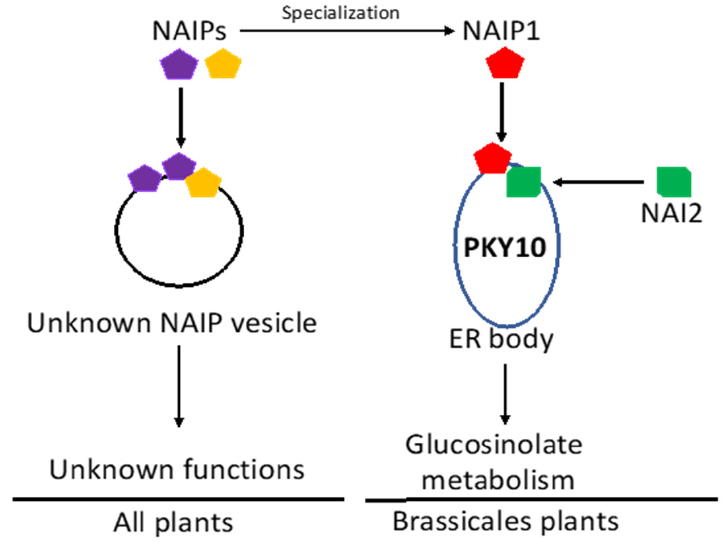
Figure 4. A proposed model for the evolutionary origin of the ER bodies. NAIP proteins are critical components for a family of ER-derived vesicles that are present in all plants. NAIP1 became specialized to be specifically associated with ER bodies through interaction with NAI2. ER bodies accumulate atypical myrosinases such as PYK10 and play a critical role in glucosinolate metabolism in defense against herbivores and pathogens.